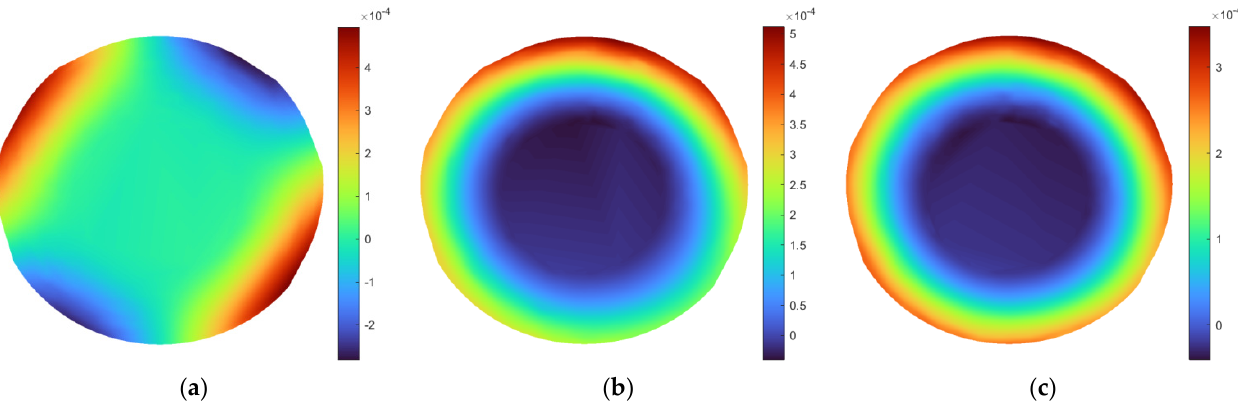
Figure 9. The interpolated mode shapes of the smaller disk: ( a – c ) subsequent considered mode shapes.